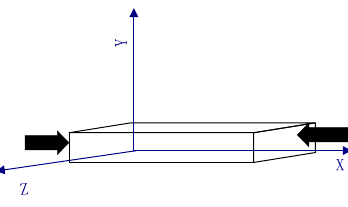
Figure 2. The schematic of the compression testing geometry.